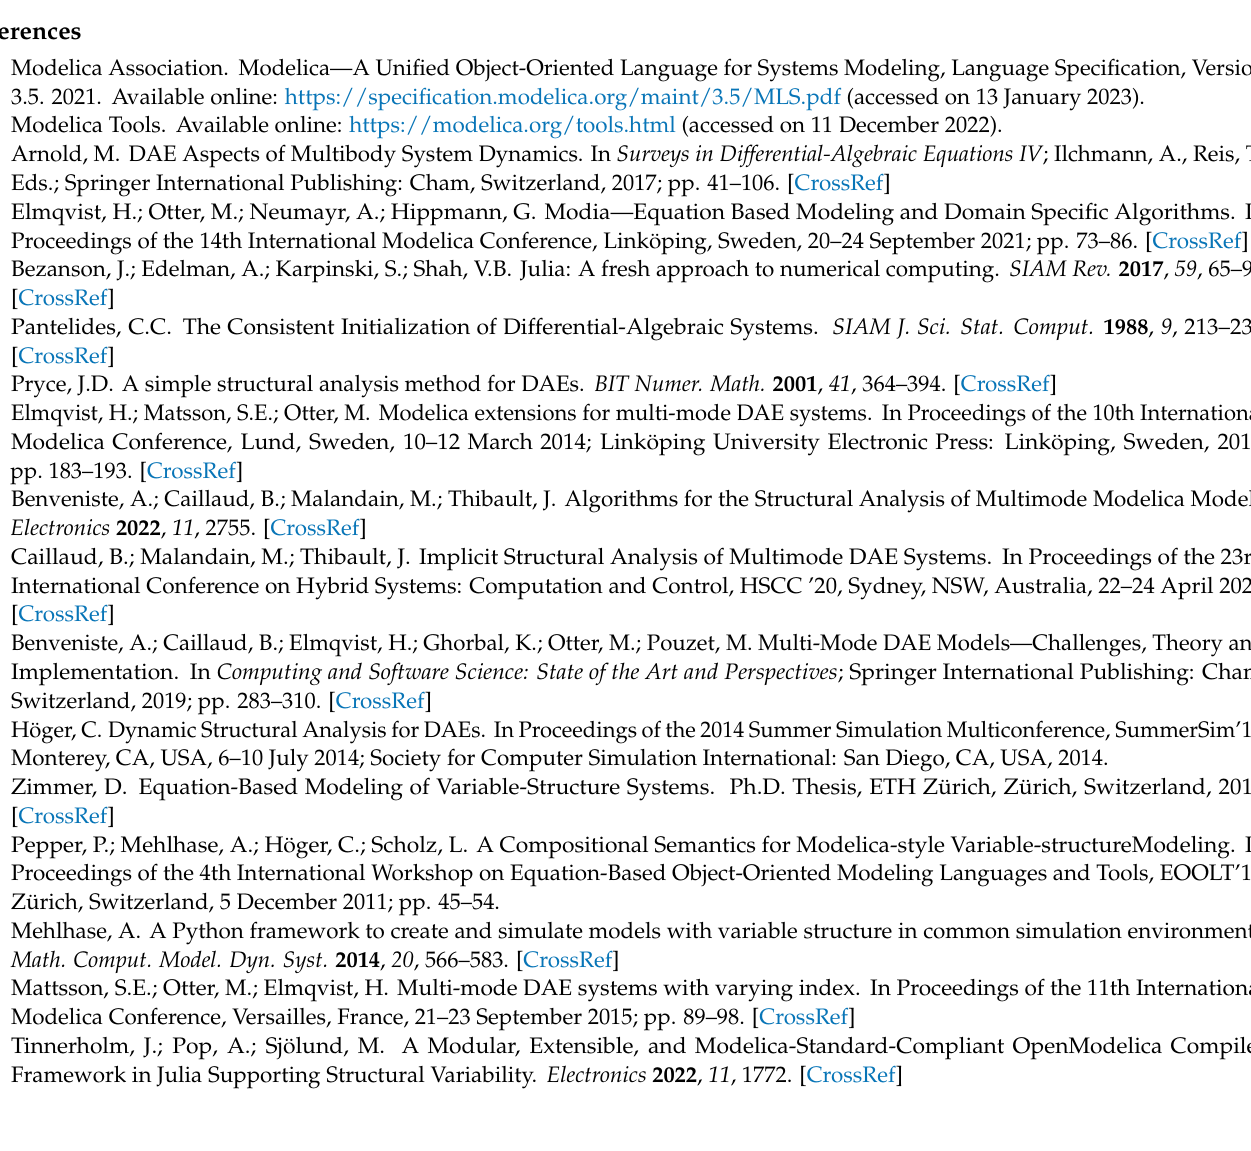
Figure A3. Plots of the variables from the simulation of model RocketSystem of Listing A7. Variable values are not shown in the plots, if they are not defined in the respective